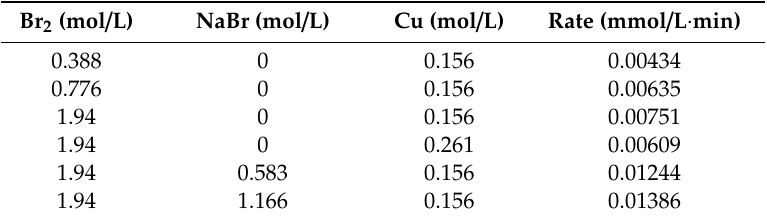
Table 9. Gold dissolution rates at various concentrations of Br 2 , NaBr and Cu at 23.5 ◦ C and 400 RPM. Br 2 (mol / L) NaBr (mol / L) Cu (mol / L) Rate (mmol / L ·